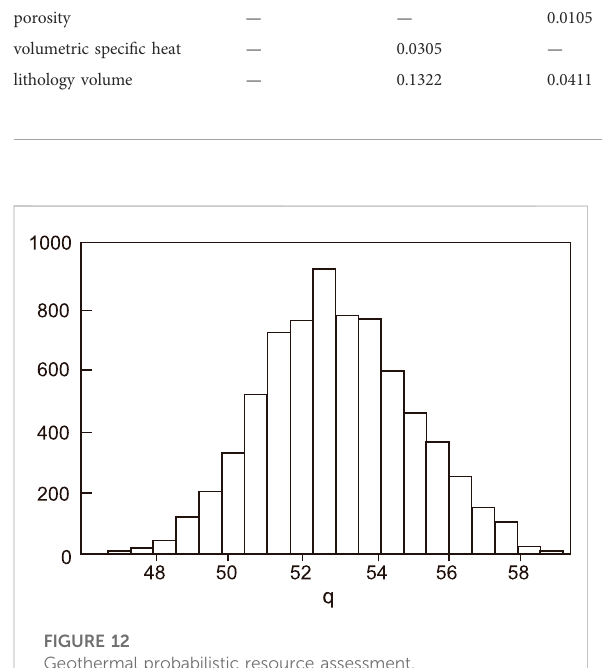
FIGURE 12 Geothermal probabilistic resource